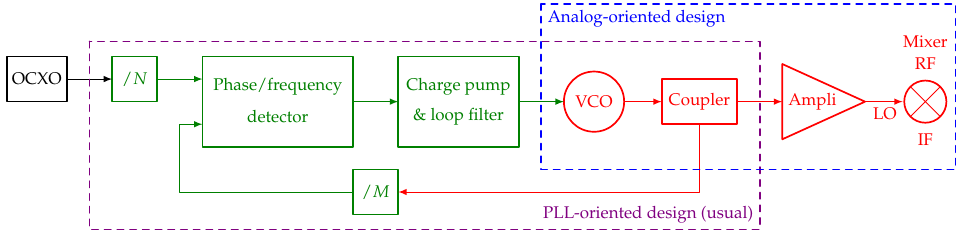
Figure 3. Two approaches for the design of a frequency converter. PLL oriented (purple box) starts with PLL integration and then with adding the modules for interfacing with the mixer. Analog- oriented design (blue box) considers the mixer’s performances together with the VCO design (impact of the coupler topology, of the LO access load of the mixer, output power of the VCO for the gain conversion optimization) and then combines with the PLL modules. The need for a buffer amplifier, and its impact on the DC consumption and phase noise must be included in both